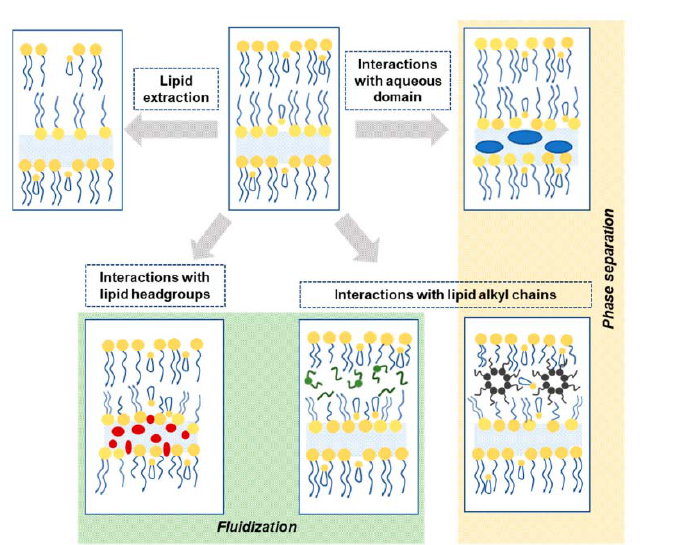
Figure 8. Schematic view of the modes of action of CPEs [4]. Reprinted with permission from ref. [4]. Copyright 2021 MDPI